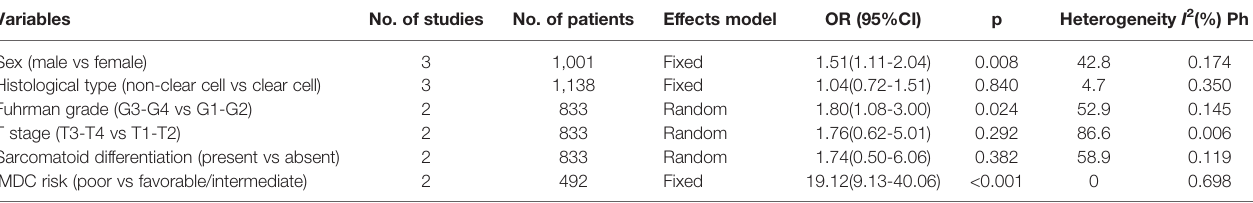
TABLE 3 | The meta-analysis of association between SII and clinicopathological factors in patients with